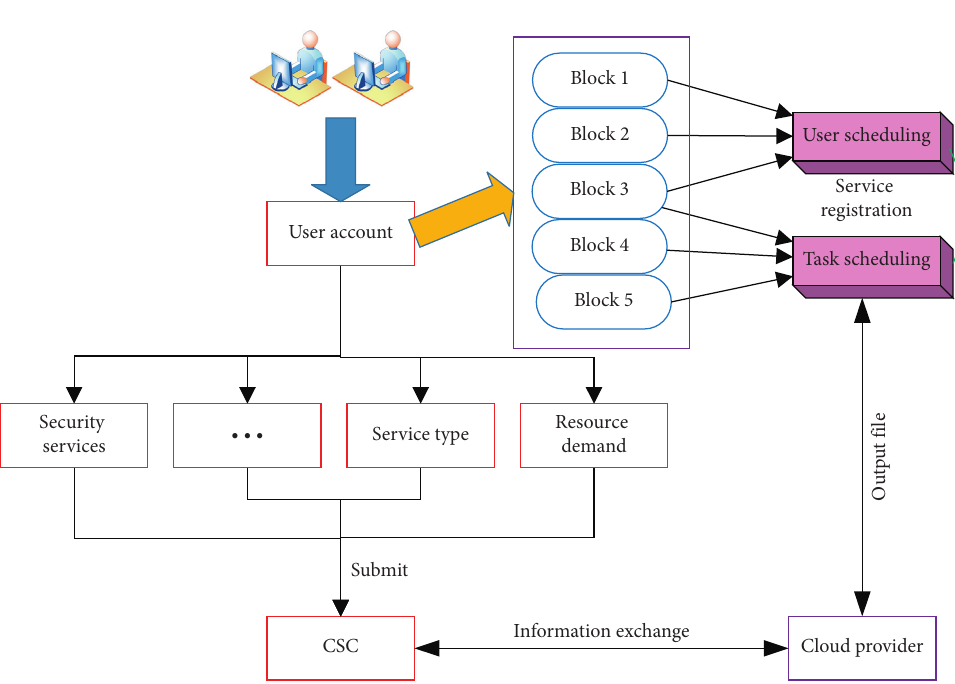
Figure 5: Scheduling algorithm